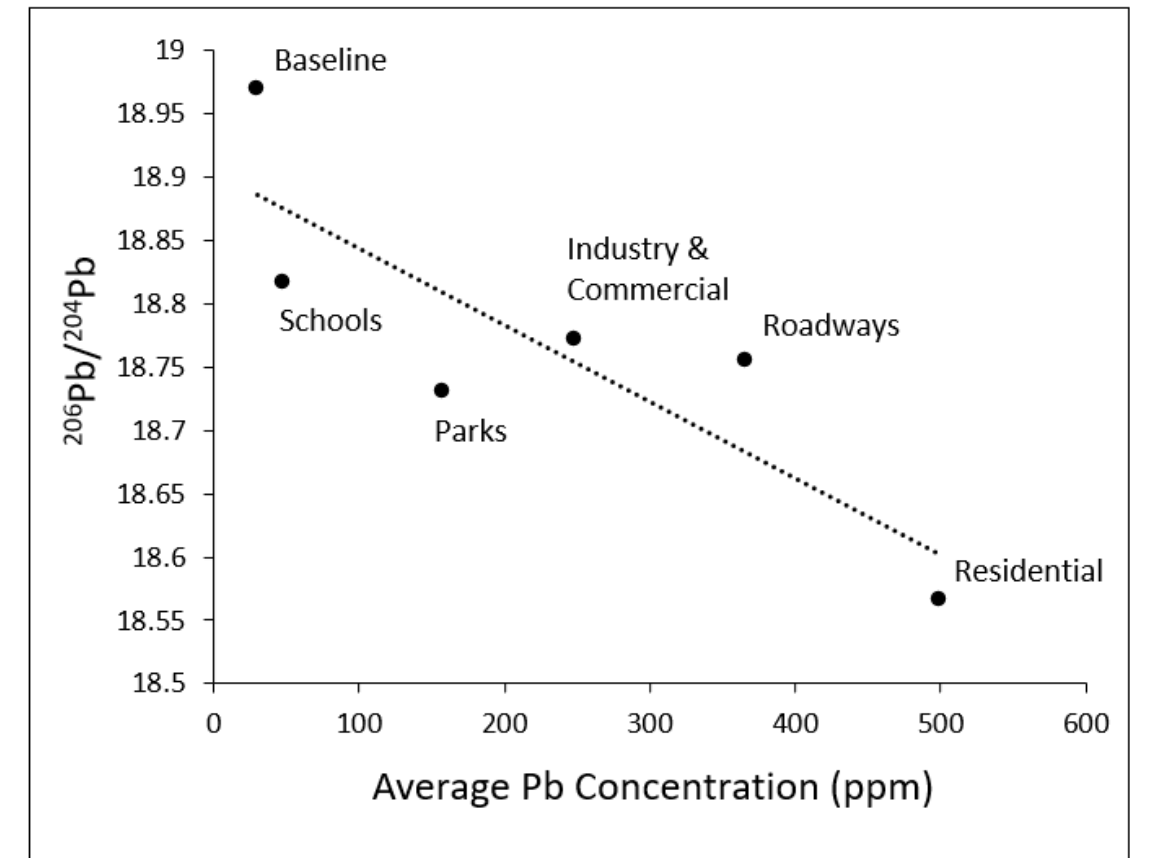
Figure 5. Ratio of 206 Pb/ 204 Pb plotted against absolute Pb concentrations (as measured in shallow soil samples) after averaging by land-use type.